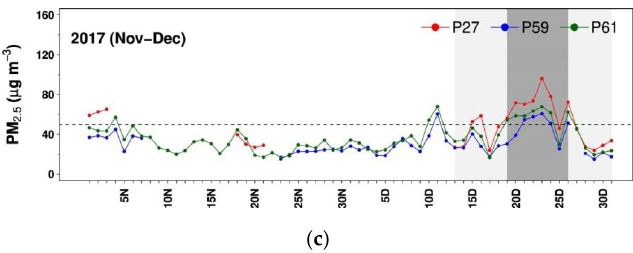
Figure 2. ( a ) Monthly particulate matter (PM) with a size less than or equal to 2.5 µm (PM 2.5 ) and number of haze days observed at P61 over 2015 – 2017; ( b ) daily PM 2.5 during haze episode 1 (EP1); ( c ) daily PM 2.5 during haze episode 2 (EP2). In ( a ), the filled and unfilled circles are the averages, the vertical bars are the standard deviations, and the x -axis labels (J, F, M, ..., N, and D) denote the months of the year. In ( b , c ), the suffixes N, D, J, and F on the x-axis labels correspond to November – February, respectively. In ( b , c ), the dark-gray shading marks the HZ periods, and the light-gray shading marks the pre-haze event (HZ) and post-HZ periods for each haze episode.